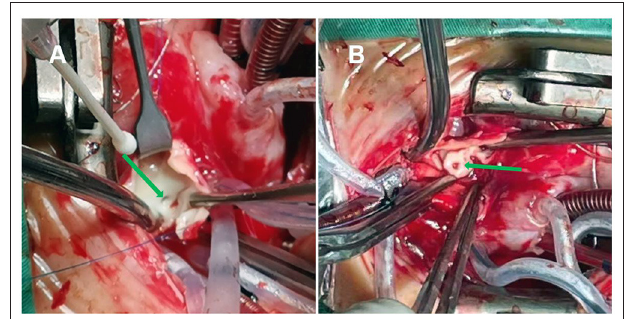
FIGURE 2 | (A) The opening of the left pulmonary artery in the posterolateral wall at the beginning of the right pulmonary artery (green arrow). (B) The left coronary artery was buttoned off from the pulmonary artery wall (green arrow).